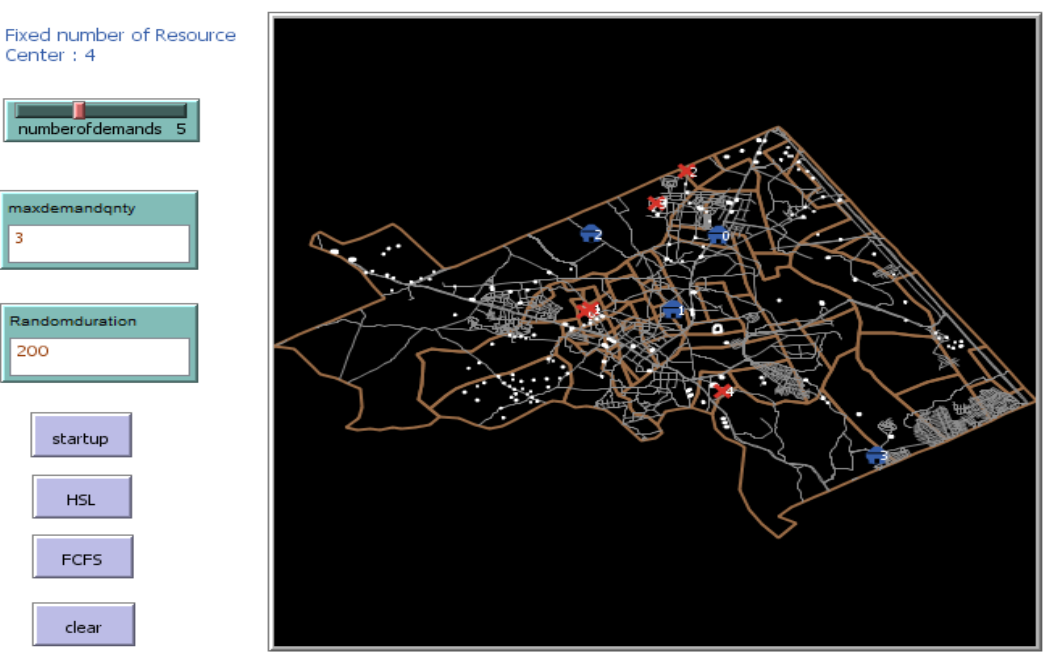
Figure 5. A screenshot of the NetLogo environment for experiment 1 given in Table 3.